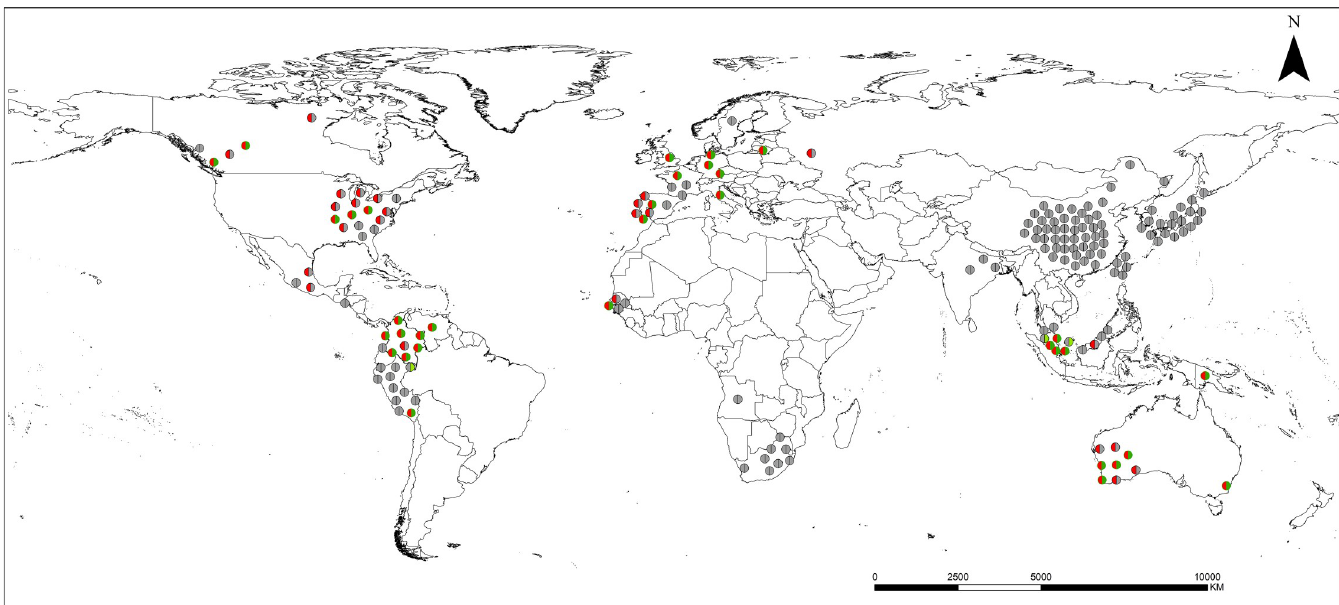
Fig 6. Geographic distribution of the H . pylori strains harbouring the HP1283/1578 genes. The geographic origins of the 177 strains (S3 Table) were dot-graphed on the world map. The presence of HP1283 is coded red, the presence of HP1578 is coded green, whereas their absence is coded gray.